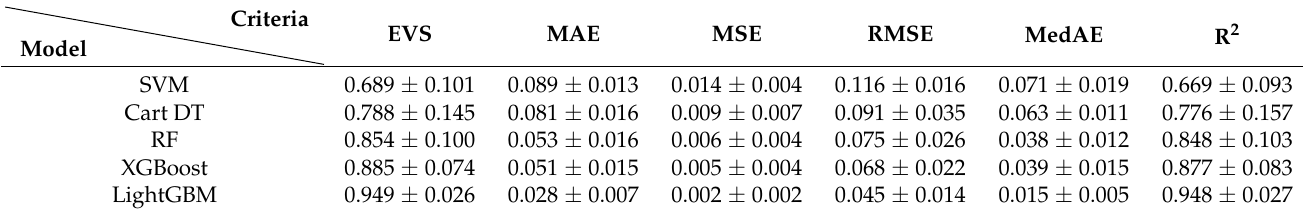
Table 4. Comparison of the machine learning model